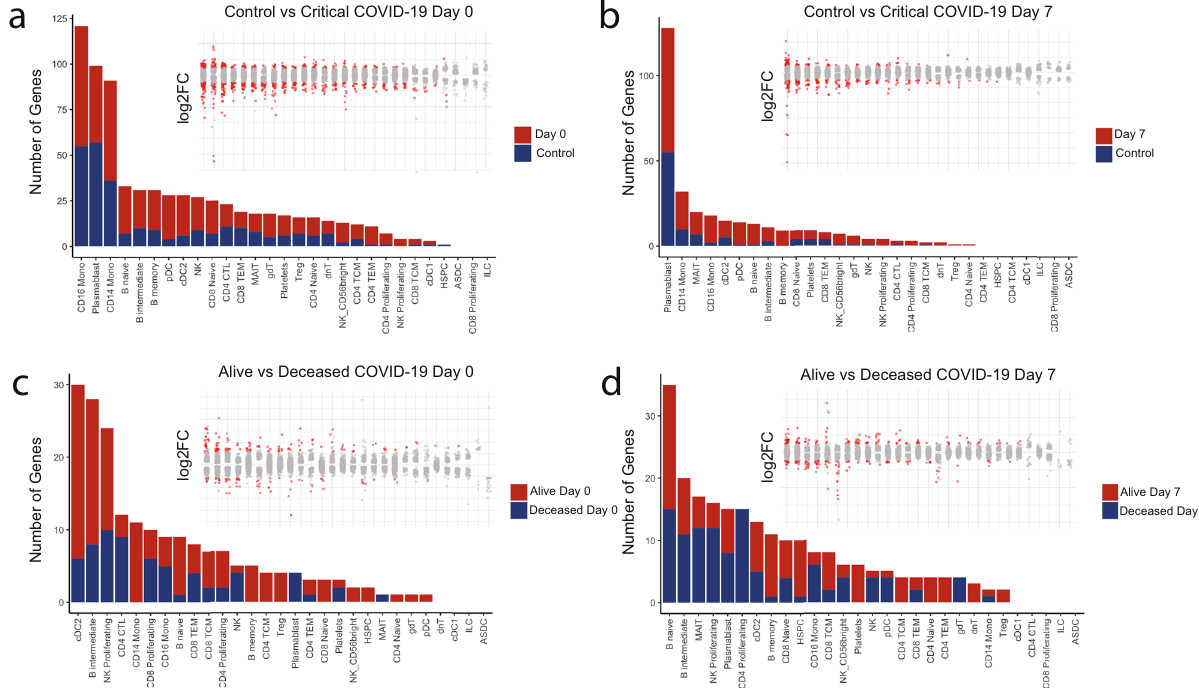
Fig. 2 Single-cell transcriptomics reveal number and magnitude of differential gene expression in speci fi c cell populations during the evolution of critical COVID-19. Number of differentially expressed genes (adjusted p -value < 0.05 and log2FC > 0.58) in annotated populations between a Control versus Day 0, b Control versus Day 7, c Alive vs Deceased Day 0, and d Alive vs. Deceased Day 7. Dot plots within each sub fi gure show magnitude of fold- change for each cell type in the same order as the corresponding bar plot. Red dots in dot plots denote differentially expressed genes that reached statistical signi fi cance. Differential expression analysis was performed using the default Seurat non-parametric Wilcoxon rank-sum